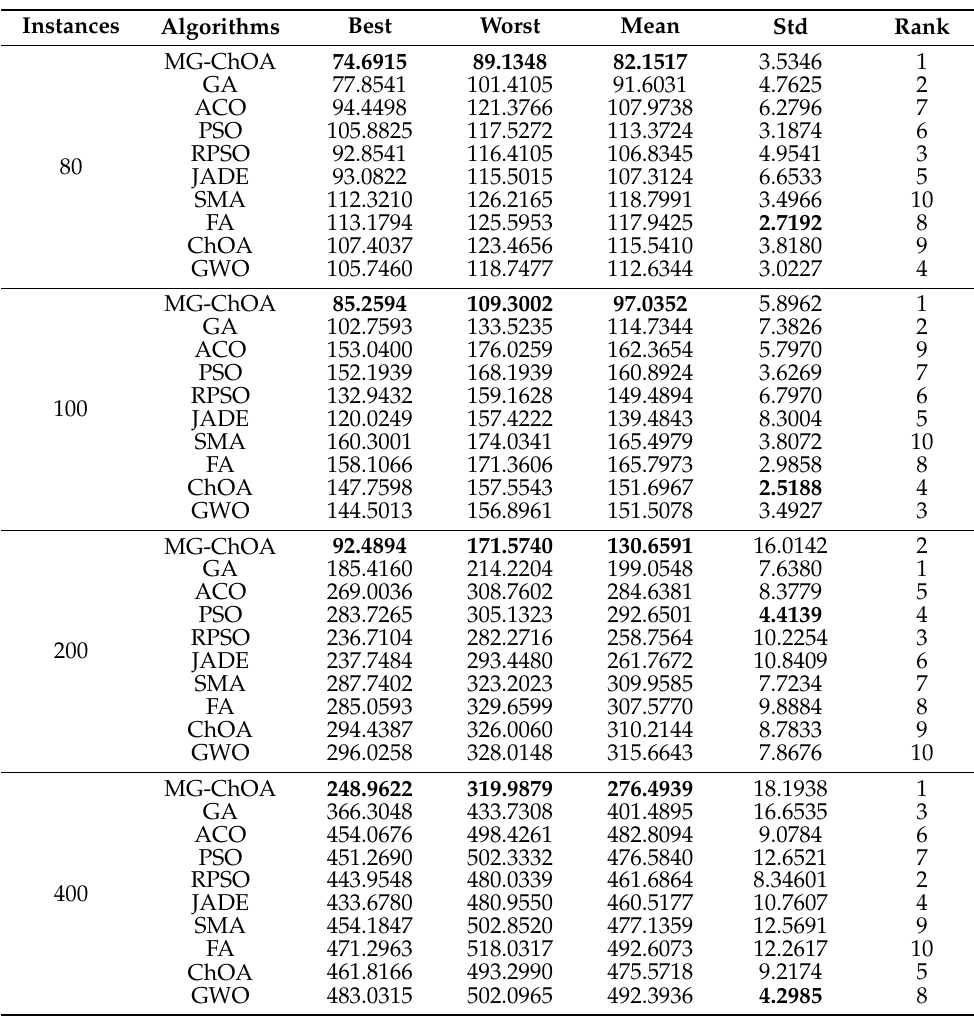
Table 4. Experimental results of algorithms for instances of 80, 100, 200, and